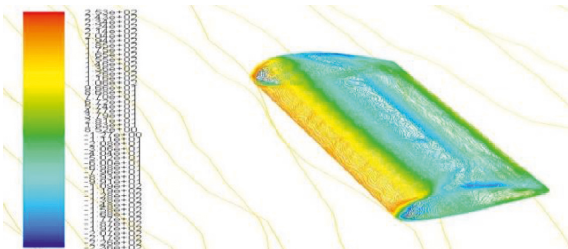
Figure 7: Total pressure at 15 ° AOA.